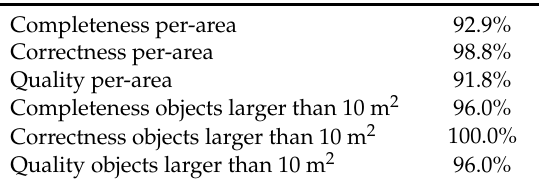
Table 6. Quality metrics of the building reconstruction results (per-area